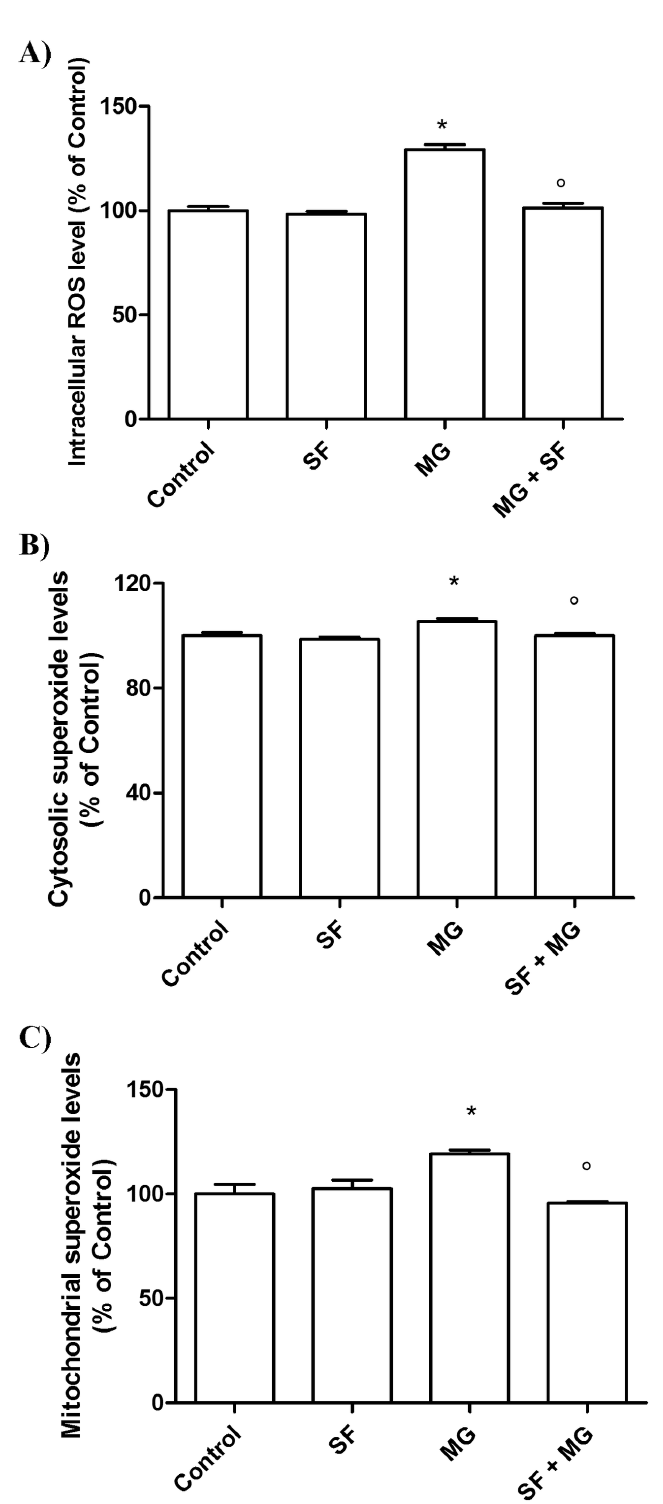
Figure 7. Fluorimetric assays of SF effect on MG-induced ROS generation. Cardiomyocytes were treated with 5 µM SF for 24 h before addition of 1 mM MG. ( A ) Intracellular ROS levels were determined with the peroxide-sensitive probe DCFH-DA. ( B ) Cytosolic ROS levels were determined with DHE. ( C ) Mitochondrial ROS levels were determined with MitoSox. Data are expressed as a percentage compared to control and are presented as mean ± SD, n = 4 in each group,* p<0.05 vs Control; ° p<0.05 vs MG. doi: 10.1371/journal.pone.0083283.g007 PLOS ONE |